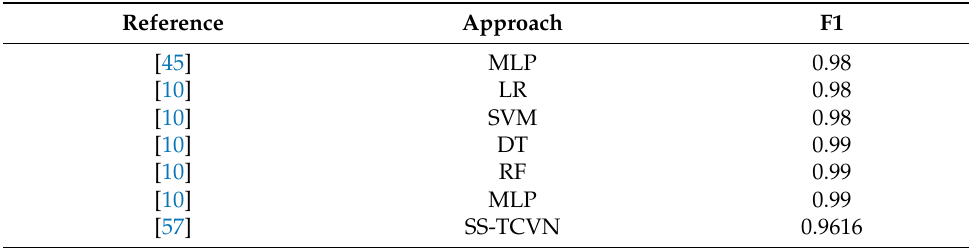
Table 8. Comparison of cited works using the DS2OS data-set.